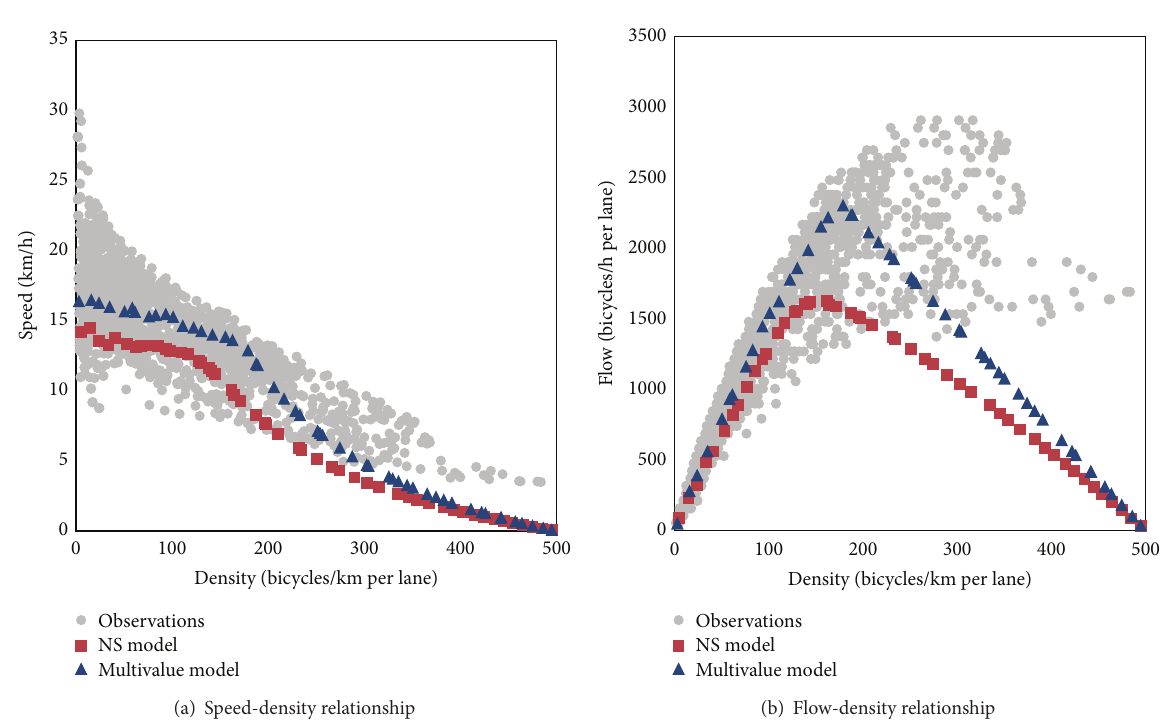
Figure 8: Observed and simulated speed-density and flow-density